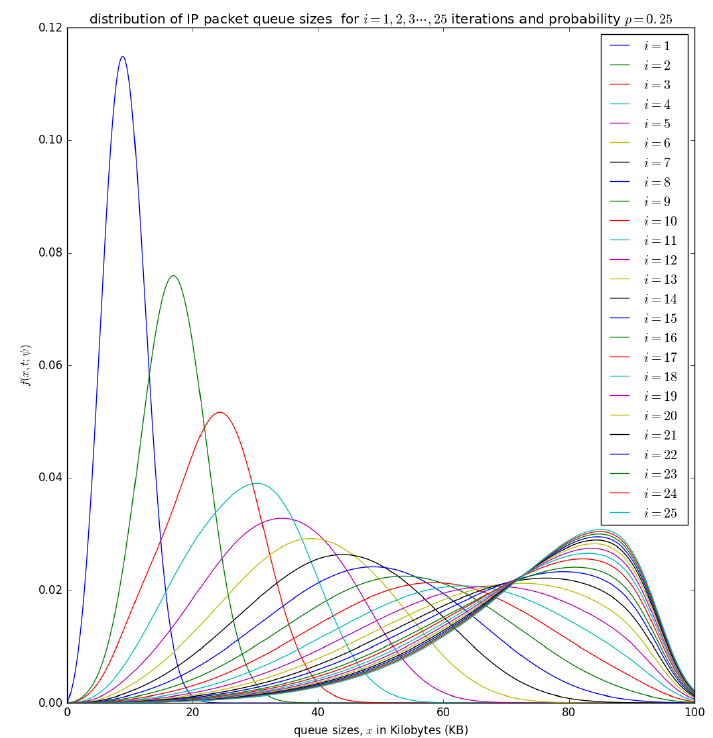
Figure 14. The distribution of the aggregation queue size, f ( x , t ; ψ ) if p = 0.25 for consecutive iterations as in Equation (18) i = 1 . . . 25.